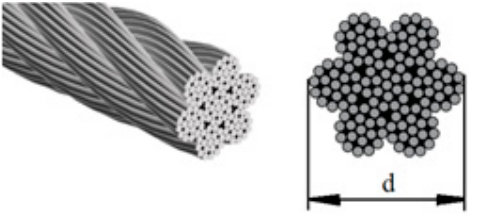
Figure 1. Steel rope 6 × 19 IWRC; d is the actual diameter of the rope.